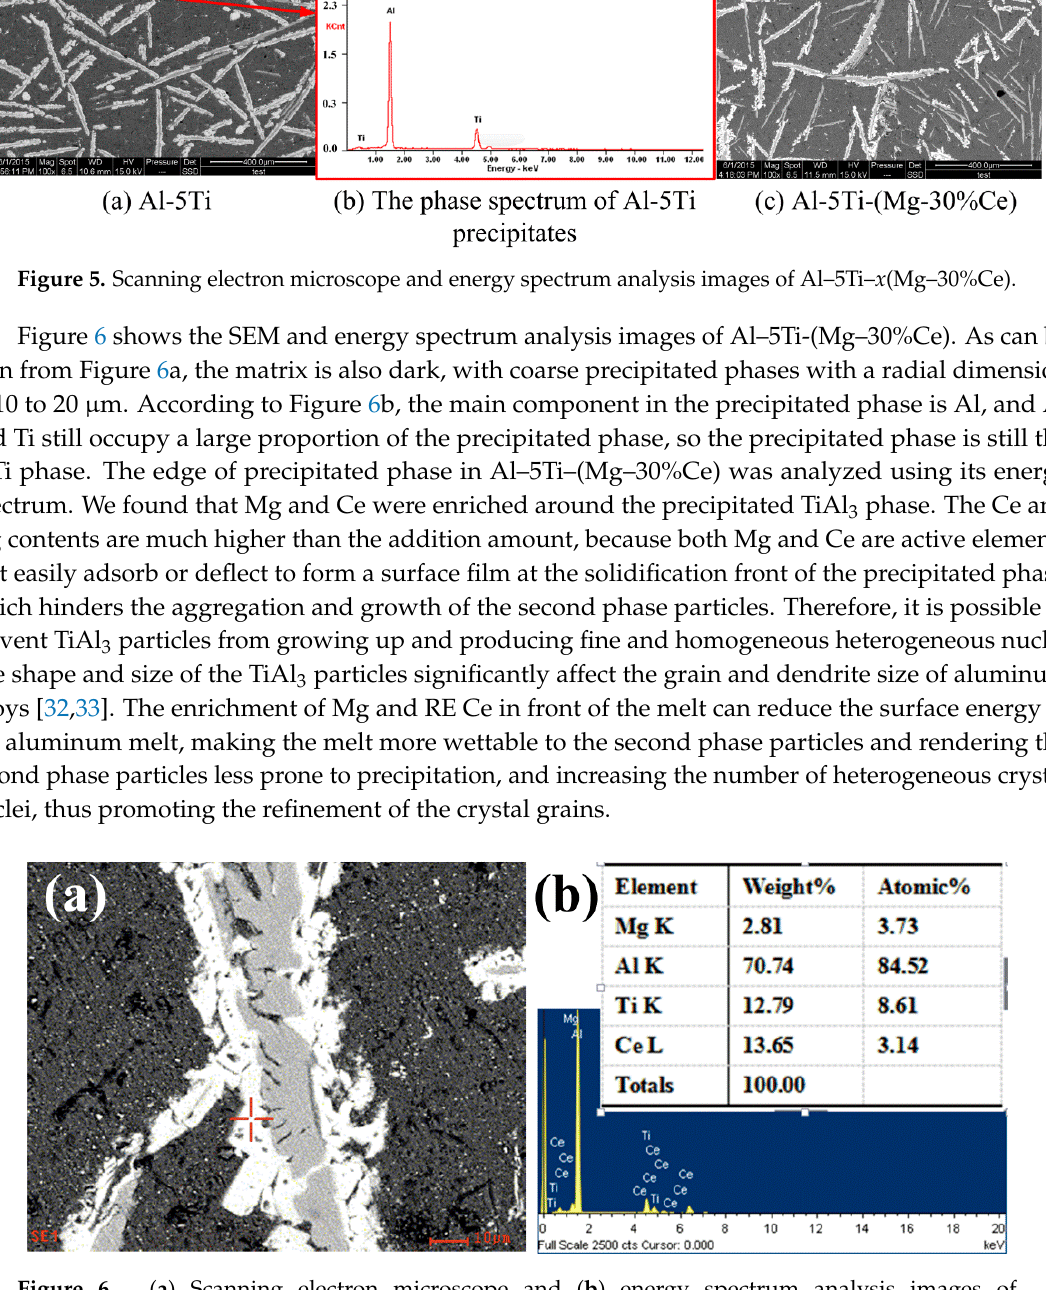
Figure 6. ( a ) Scanning electron microscope and ( b ) energy spectrum analysis images of Al–5Ti-(Mg– 30%Ce).